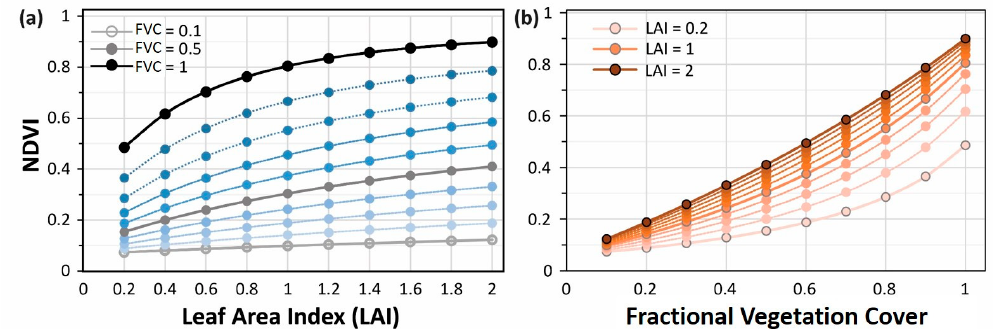
Figure 1. Changes in the Normalized Di ff erence Vegetation Index (NDVI) as a function of increasing Fractional Vegetation Cover (FVC) and Leaf Area Index (LAI): ( a ) NDVI values per pixel with increasing LAI per unit area of vegetation cover, for di ff erent FVC levels within the pixel (light to dark colors); ( b ) NDVI values per pixel with increasing FVC within the pixel, for di ff erent level of LAI per unit area of vegetation cover (light to dark colors).